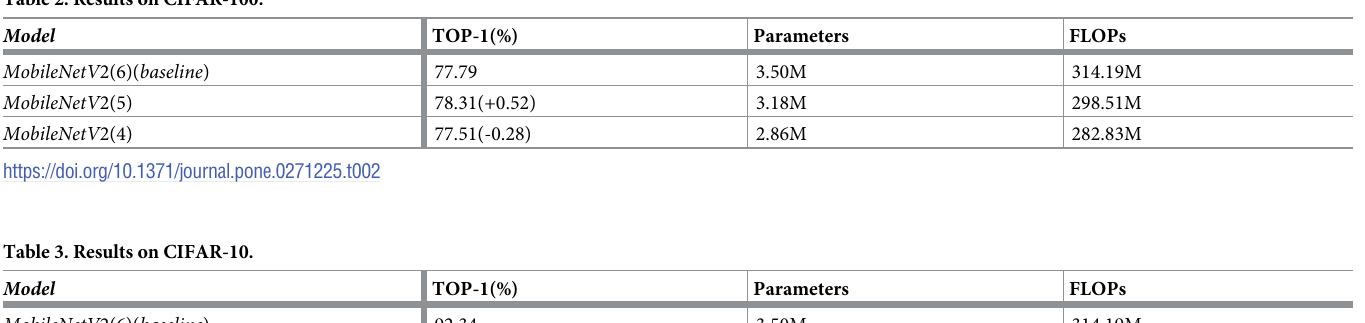
CIFAR-10 dataset, respectively. The ImageNet-100 dataset contains 129,395 training images and 5000 test images with 100 categories. CIFAR-100 dataset has 100 categories, and each cate- gory contains 600 images. The training set of CIFAR-100 dataset contains 50000 images that is obtained by selecting 500 images from each category. The remaining 10000 images are used as the training set. CIFAR-10 dataset has 10 categories, and each category contains 6000 images. The training set of CIFAR-10 dataset contains 50000 images that is obtained by selecting 5000 images from each category. The remaining 10000 images are used as the training set. Table 1 shows the Top-1accuracy, Parameters, and FLOPs for different numbers of the Bottleneck module in the fourth stage on the ImageNet-100 dataset. The MobileNetV2(6), MobileNetV2 (5), and MobileNetV2(4) are MobileNetV2 networks based on 6, 5, and 4 Bottleneck modules in the fourth stage, respectively. In Table 1, the TOP-1 accuracy of MobileNetV2(6) is the low- est. Compared with MobileNetV2 (6), the TOP-1 accuracy of MobileNetV2(5) is increased by 0.66% and the MobileNetV2(4) is increased by 0.35%. The MobileNetV2(5) has the highest TOP-1 accuracy. Table 2 shows the results on CIFAR-100. In Table 2, Compared with Mobile- NetV2(6), the TOP-1 accuracy of MobileNetV2(5) is increased by 0.52% and the MobileNetV2 (4) is decreased by 0.28%. The MobileNetV2(5) still has the highest TOP-1 accuracy. Table 3 shows the results on CIFAR-10. In Table 3, Compared with MobileNetV2(6), the TOP-1 accu- racy of MobileNetV2(5) is increased by 0.55% and the MobileNetV2(4) is decreased by 0.36%. The MobileNetV2(5) still has the highest TOP-1 accuracy. From Tables 1–3, we can see that parameters and FLOPs increase with the increase of Bottleneck module number. Although the MobileNetV2(4) network has higher accuracy than MobileNetV2(6) on ImageNet-100 and lower accuracy on CIFAR-100 and CIFAR-100 datasets, the MobileNetV2(5) network still has the highest accuracy on ImageNet-100, CIFAR-100 and CIFAR-10 datasets. Therefore, we reduce the number of Bottleneck modules from 6 to 5 in the fourth stage to obtain better accu- racy performance.